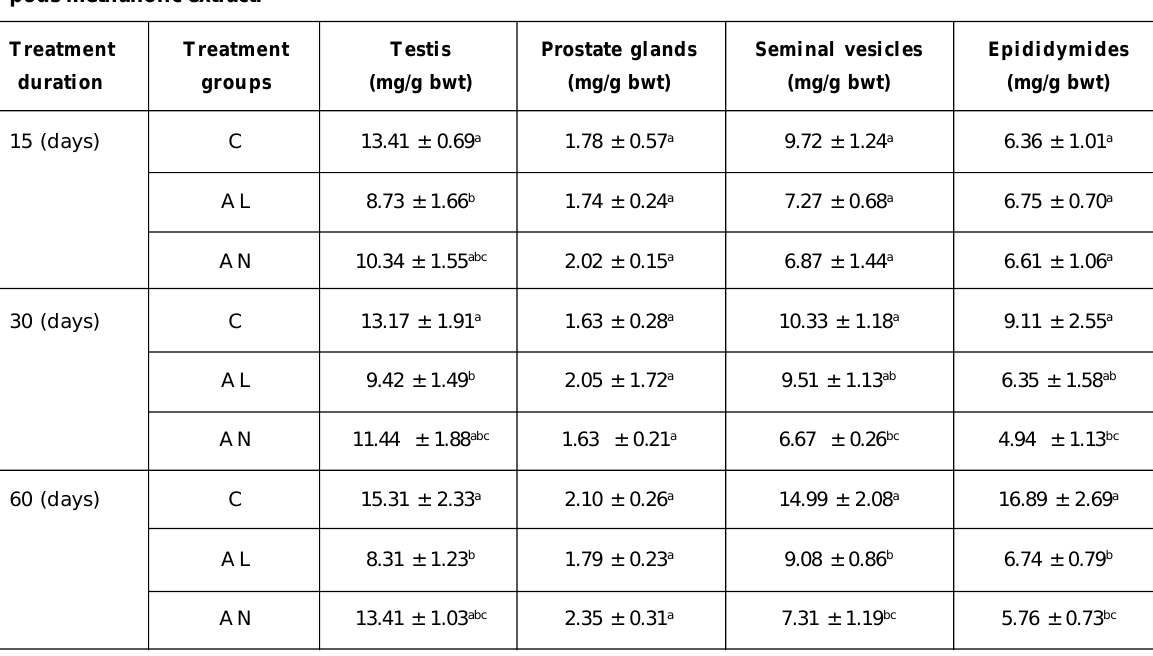
Table 3: Effect A. lebbeck and A. nilotica extracts on the weight indices of reproductive organs in the M. natalensis male rats. C = control groups, AL= A. lebbeck stem bark methanolic extract, AN = A. nilotica pods methanolic extract.